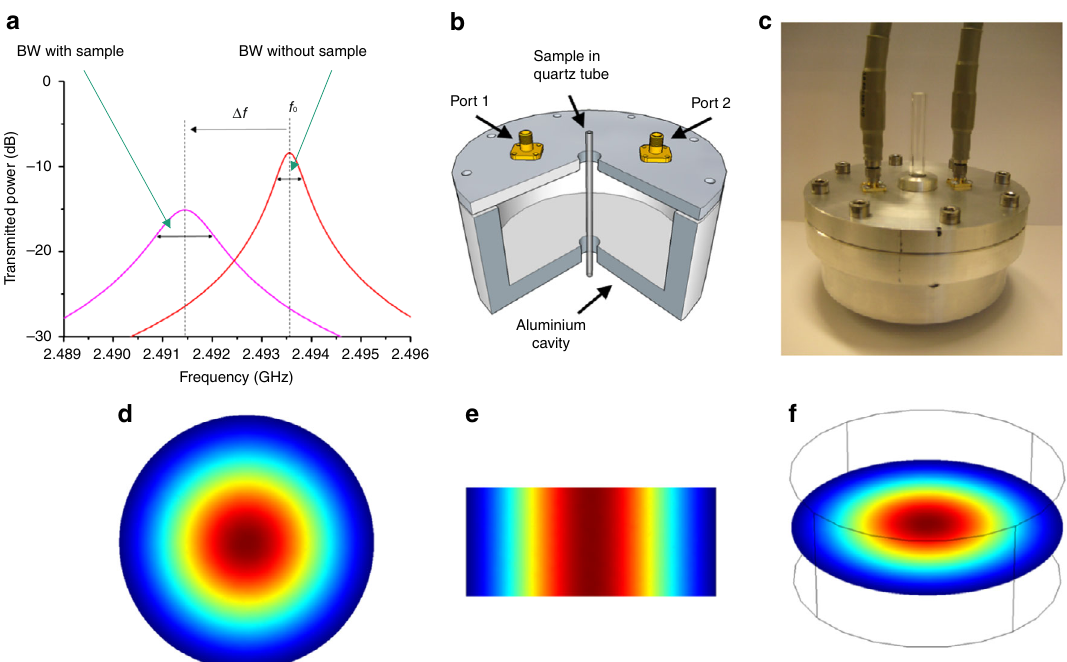
Fig. 1 Sets and electric fi eld distribution of the employed microwave cavity. a Schematic of example resonant traces showing the sample induced changes of microwave resonant cavity, which presents a shift in frequency and the change of bandwidth. b Quarter section of the perturbation cavity, cut to show the location of the sample tube (inner diameter 2 mm). c Exterior look of the microwave cavity. d Plan, e side and f slant views of the electric fi